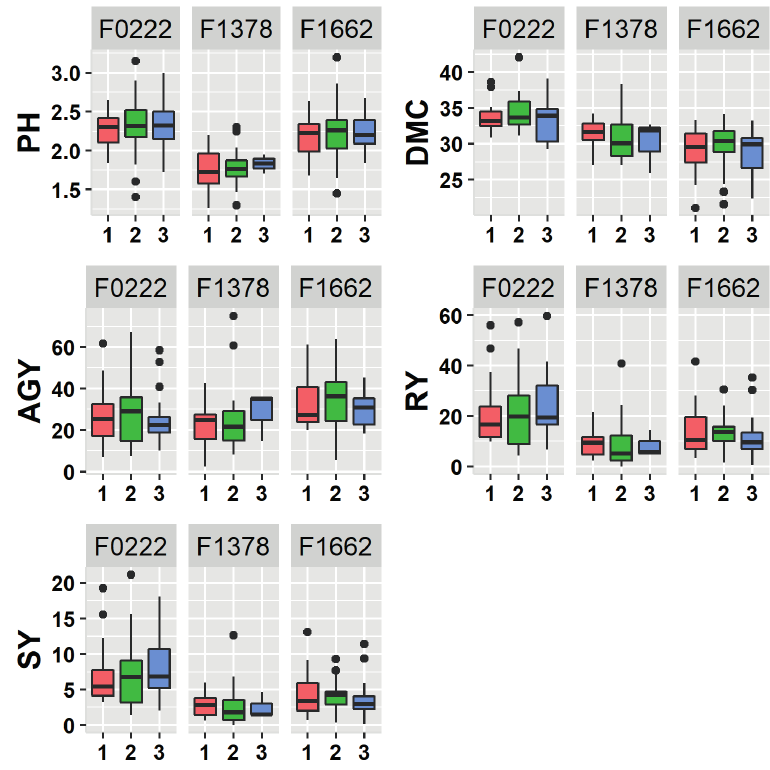
cassava individuals from the Figure 7 - Boxplot of the agronomic performance of S 1 self-pollination of accessions BGM0222 (F0222), BGM1378 (F1378) and BGM1662 (F1662), based on the inbreeding coefficient grouping ( f ). Group 1 (0.10 < f < 0.39), Group 2 (0.40 < f < 0.59), and Group 3 (f > 0.60). PH: plant height (m); DMC: root dry matter content (%); AGY: above ground yield (t.ha -1 ); RY: root yield (t.ha -1 ); SY: starch yield (t.ha -1